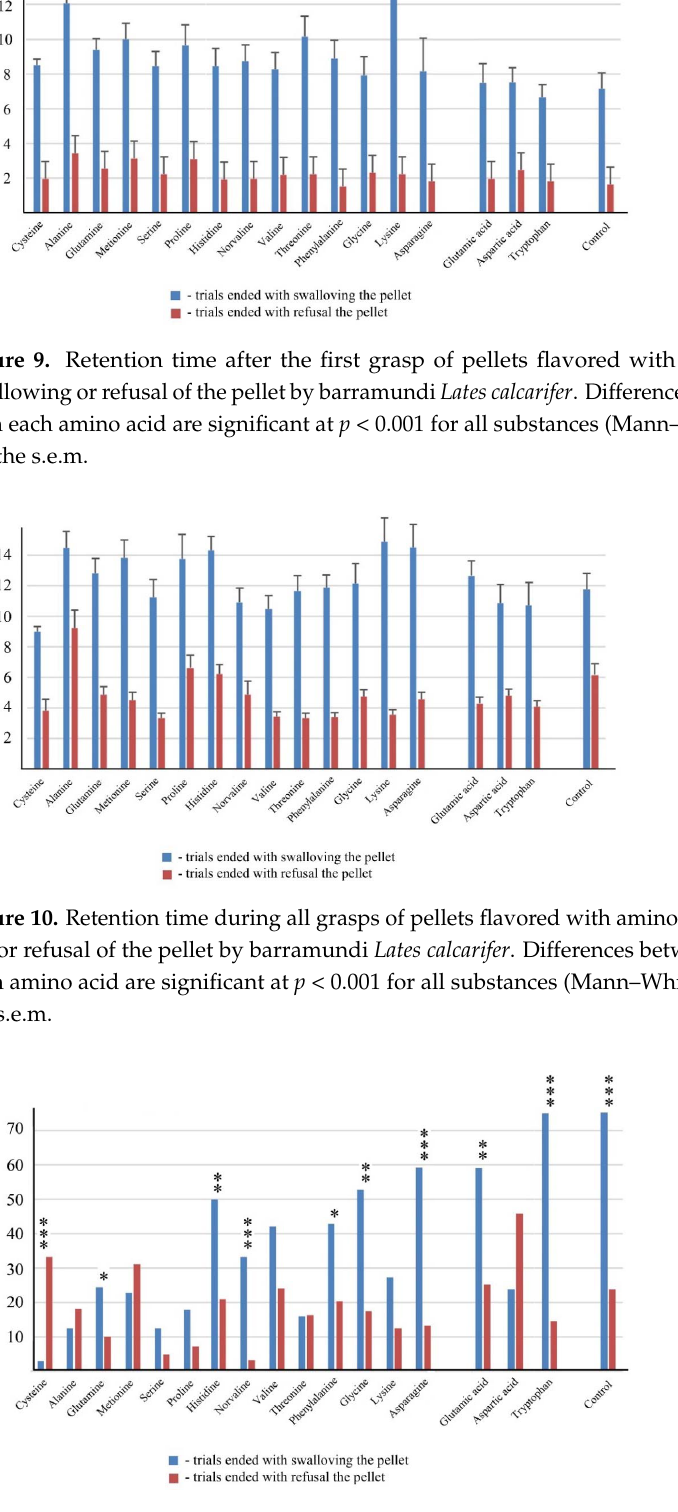
Figure 11. Fragmentation of pellets flavored with amino acids ended with swallowing or refusal of the pellet by barramundi Lates calcarifer . *, ** and ***— differences between trials ended with swal ‐ lowing and refusal of the pellet are significant at p < 0.05, p < 0.01, and p < 0.001, respectively ( χ 2 ‐ test).